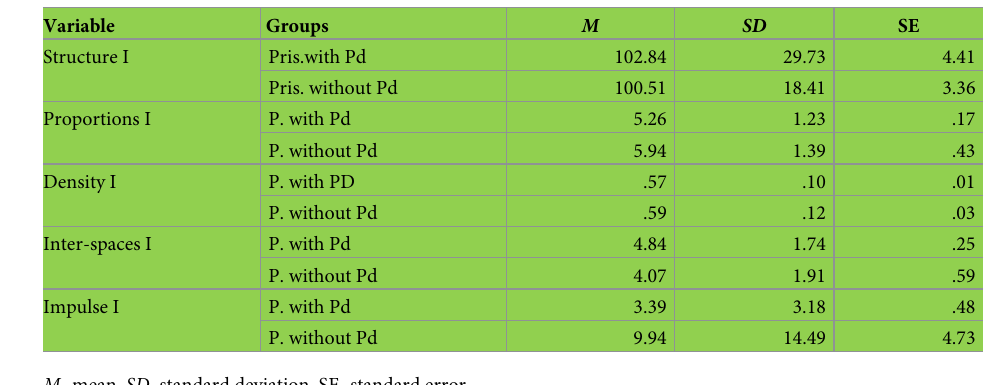
Table 4. Descriptive statistics for the